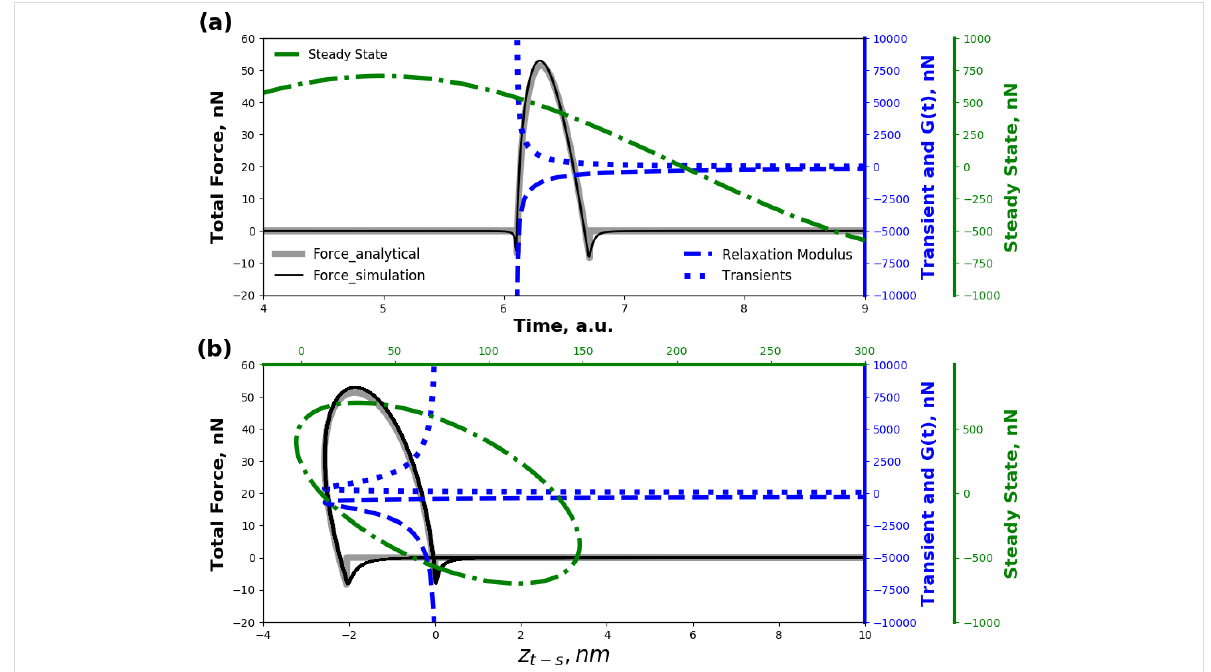
Figure 3: Results for the tip–sample force in tapping-mode AFM, decoupled trough the analytical relation derived (Equation 29). Panel (a) shows the decomposition of the force, plotted vs time, while panel (b) shows the same decomposition but as function of tip–sample position (a common repre- sentation in AFM known as force–distance curve). Both panels display the main components of the tip–sample force: i) steady-state harmonic response (green dash-dotted line, first term of Equation 29), ii) transients (blue dotted line, second term of Equation 29), and iii) relaxation modulus (blue dashed line, third term of Equation 29), when a flat-ended rigid indenter interacts in intermittent contact with a viscoelastic sample. The visco- elastic sample is polyisobutylene, represented by a Generalized Maxwell model (see Figure 1) with 26 arms. The parameters of the model were digi- talized from the data provided by Brinson and Brinson [25], who fitted the experimental data of Catsiff and Tobolsky [6], and are provided in Table S1 in Supporting Information File 1). The cantilever parameters of the AFM simulation are: k 1 = 10 N/m, f 0 = 100 kHz, R = 10 nm, Q 1 = 100, Q 2 =